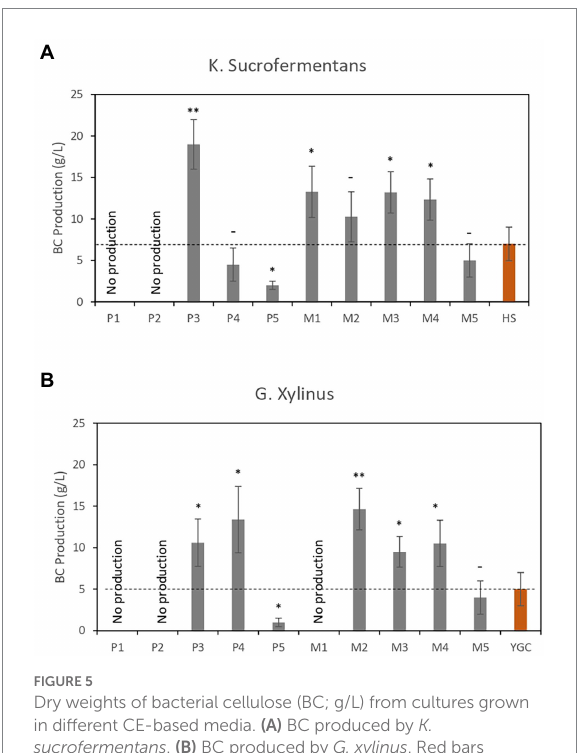
FIGURE 5 Dry weights of bacterial cellulose (BC; g/L) from cultures grown in different CE-based media. (A) BC produced by K. sucrofermentans . (B) BC produced by G. xylinus . Red bars correspond to the reference media. Data are the average of three independent experiments. Error bars are the standard deviation of three independent experiments. p -values * p < 0.05, ** p < 0.01, and – p ≥